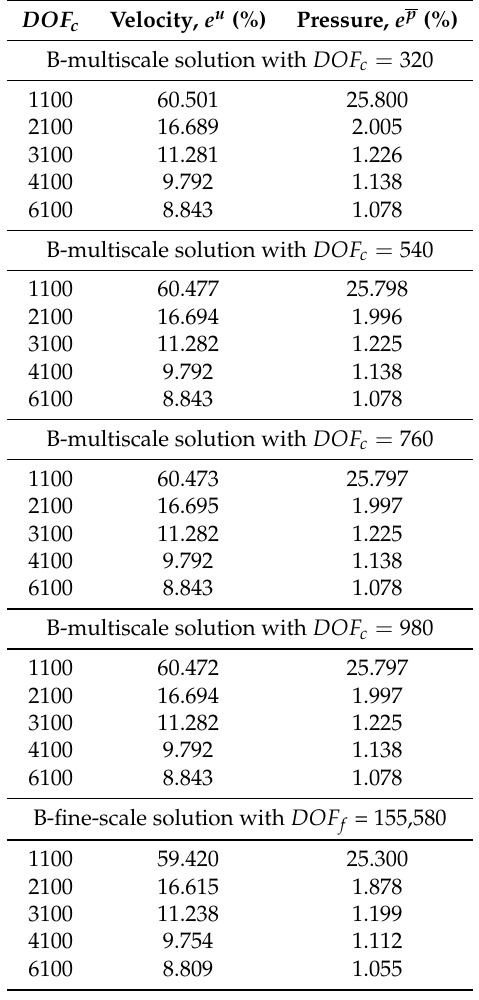
Table 2. Relative errors for velocity and pressure with different number of multiscale basis functions for 10 × 10 meshes. DOF f =